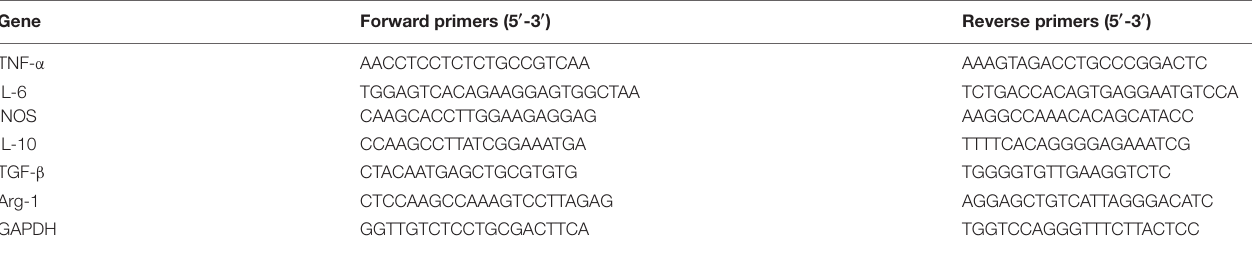
TABLE 1 | Primer sequences used for qRT-PCR analysis.